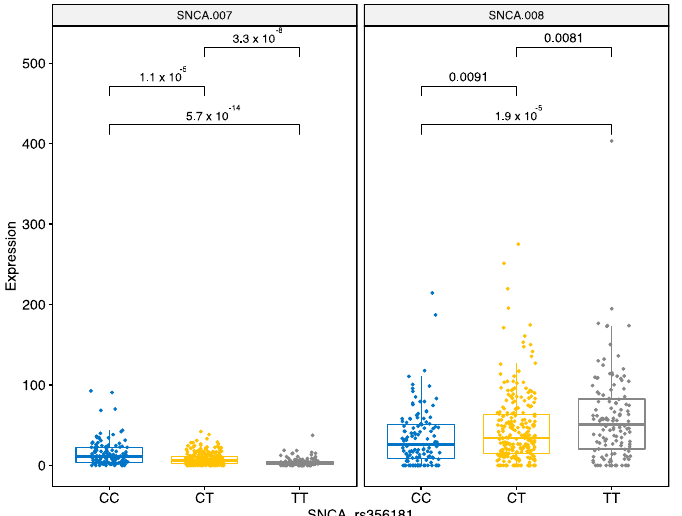
Figure 7. Different genotypes of the SNP rs356181 (CC, CT or TT) differentially regulate expression of two SNCA transcripts. The bars indicate pairwise comparisons between CC, CT and TT genotypes and respective p -values after the Wilcoxon test.